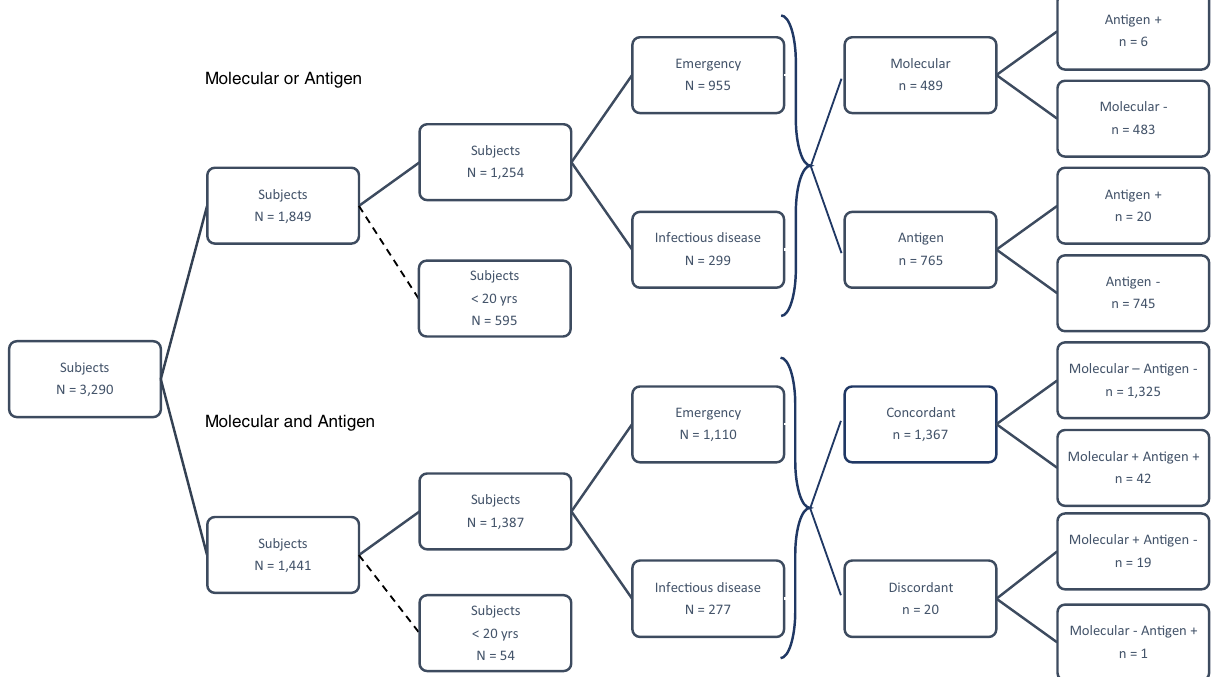
Fig. 1 | Diagram of admissions to hospital wards. Diagram showing the total number of patients from emergency and the infectious diseases wards tested with either a molecular or antigen diagnostic test and with both molecular and antigen testsintheperiodfrom15Septemberto16October2020.Subjectswhounderwent